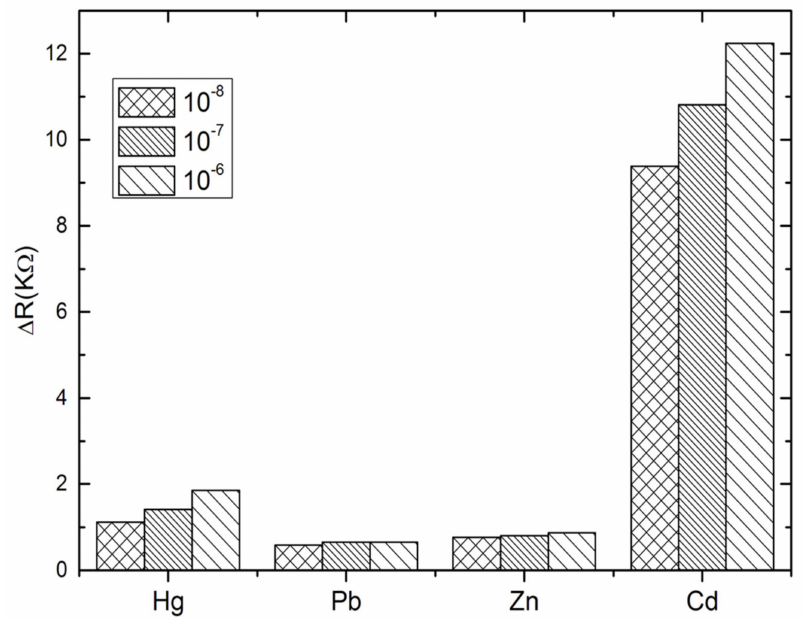
Figure 5. Selectivity studies of the aptasensor with mercury (Hg 2+ ), lead (Pb 2+ ) and Zinc (Zn 2+